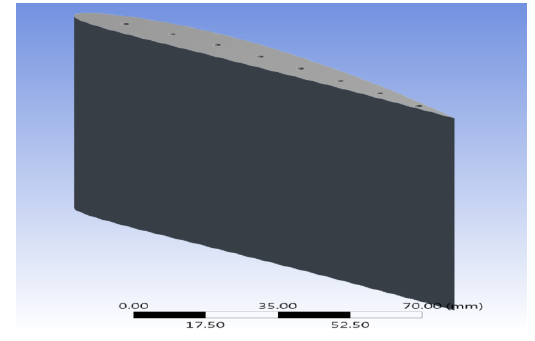
Figure 1 : Turbine blade with coating